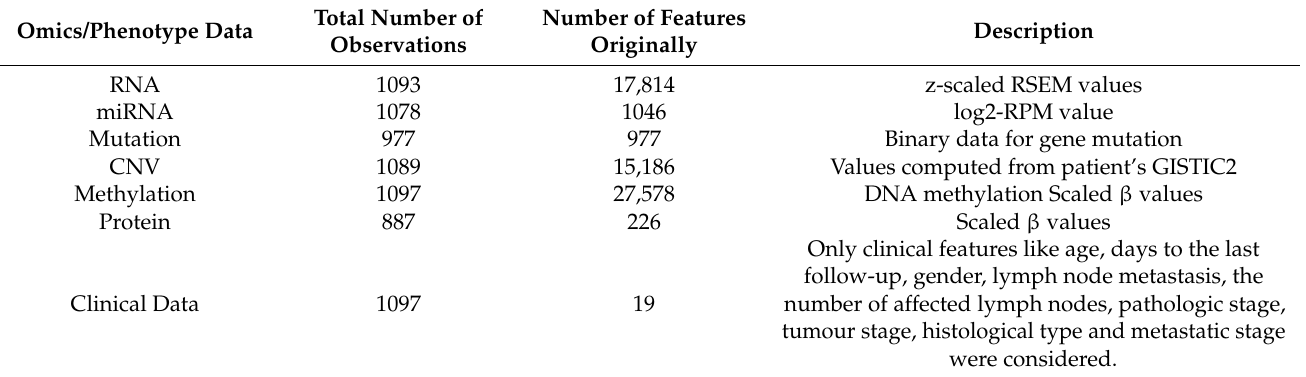
Table 2. Summarized information of omics data used to train the